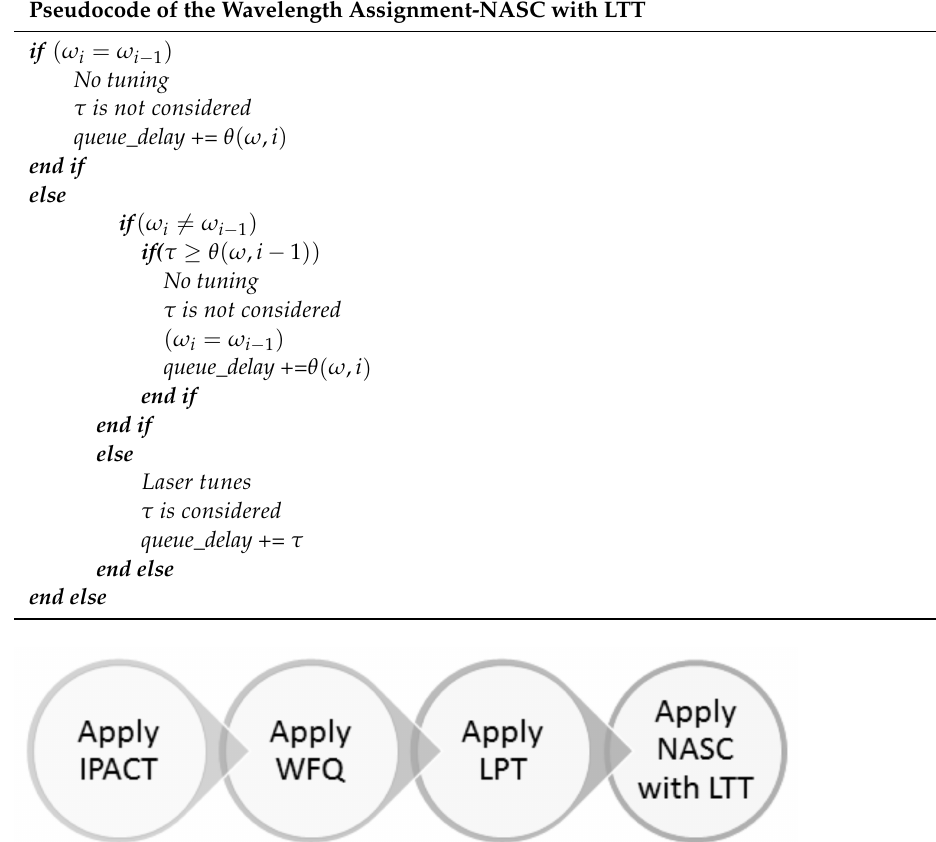
Algorithm 3. Pseudocode for NASC with LTT executed at the OLT for each cycle i .